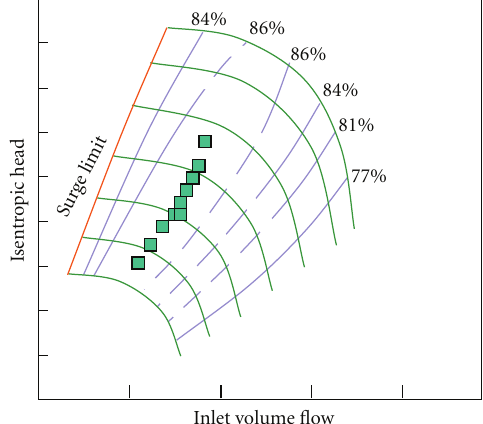
Figure 4: Typical steady state pipeline operating points plotted into a compressor performance